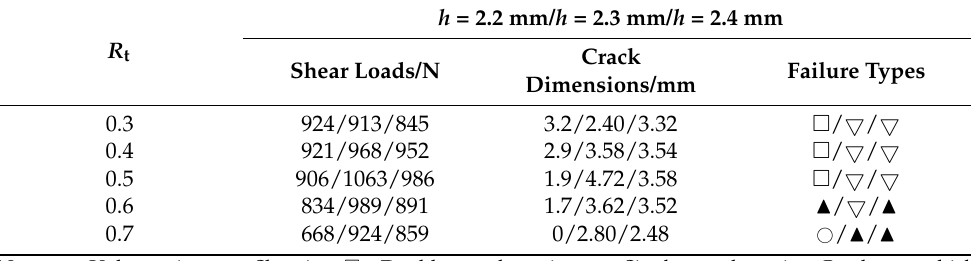
Table 4. Shear loads, crack dimensions, and joint failure types of sheet thickness t = 2 mm in shear